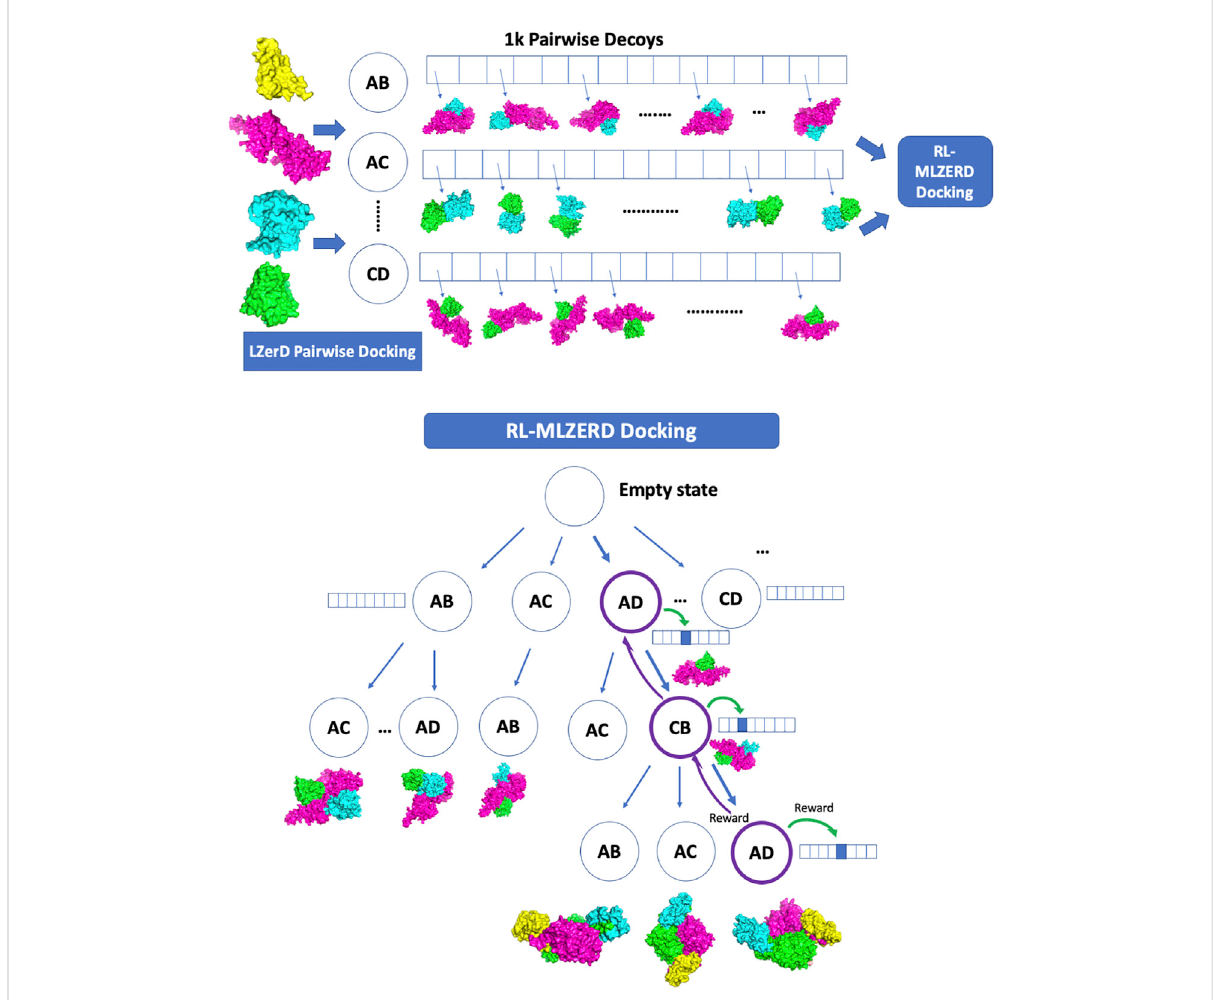
FIGURE 1 Overview of RL-LZerD. In the fi rst step, pairwise docking of every pair of subunits is performed using LZerD. 1000 decoys are selected for each pair. In the subsequent step, pairwise decoys are assembled using reinforcement learning. When an assembly of full subunit complex is successful without too many clashes, reward maybe propagated back to assembly states and decoy states used along the